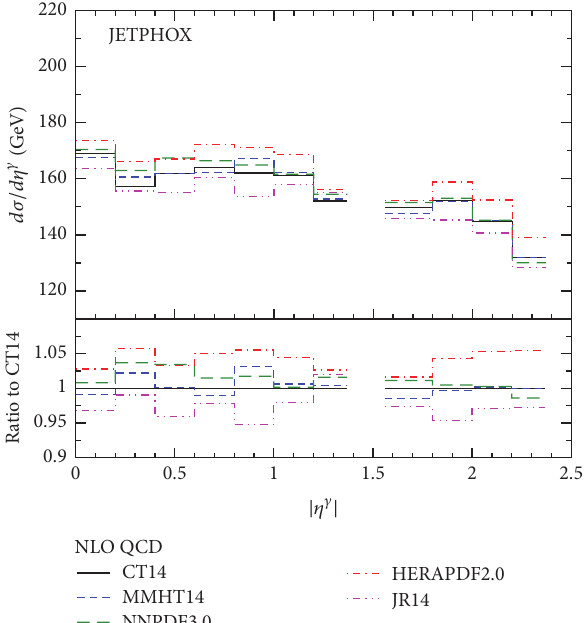
𝛾 𝑇 < 350 GeV for 𝑇